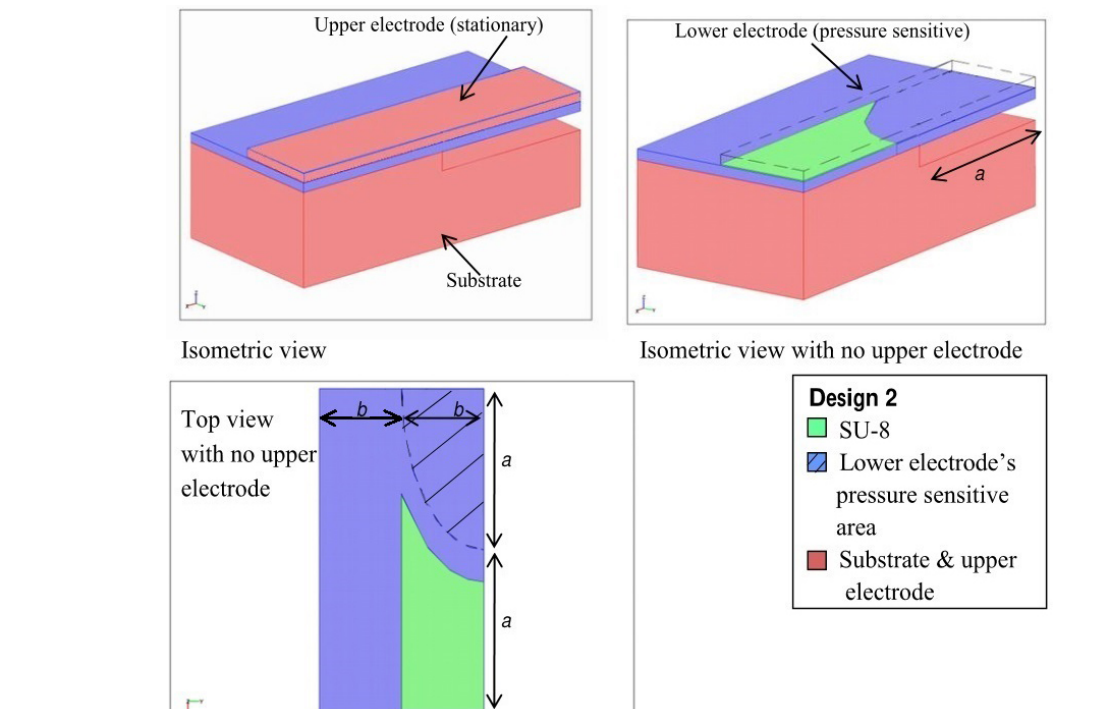
Figure 14. A three-dimensional view of a quarter of the elliptical diaphragm pressure sensor.